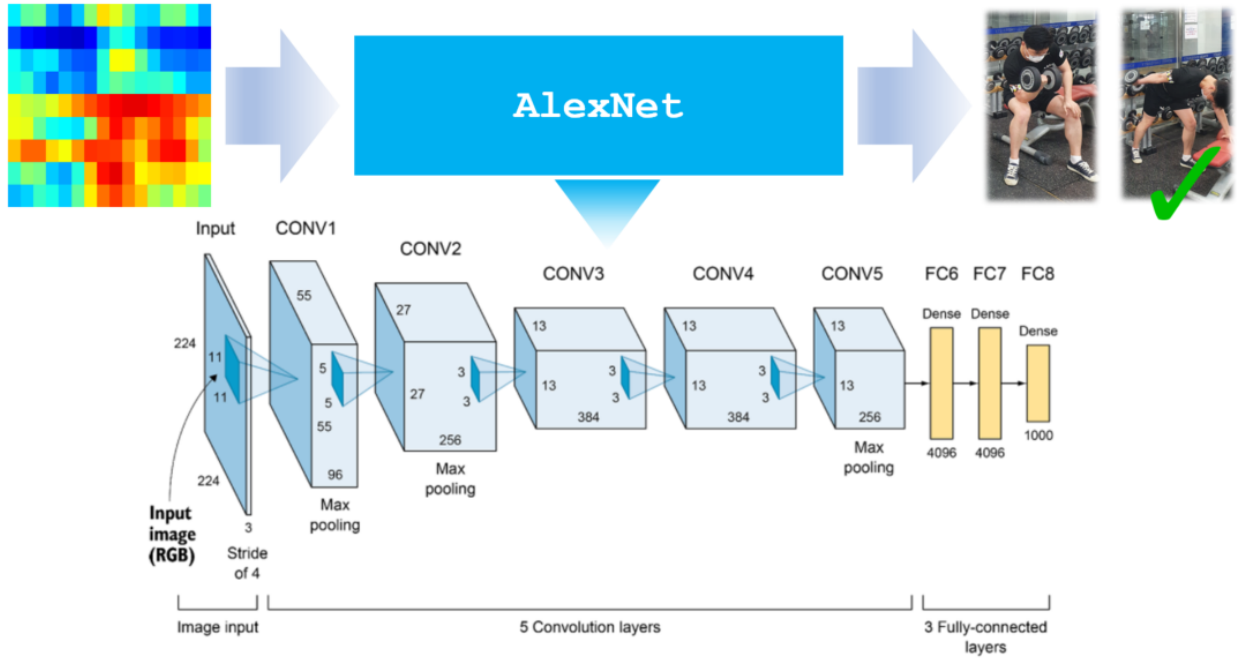
Figure 5. An example of gym-workout classification via AlexNet with an input image I easy